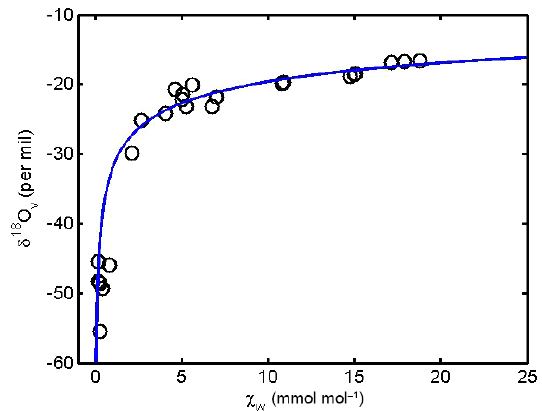
Figure 2. Aircraft observations of the oxygen isotope composition of water vapor ( δ 18 O v ) measured over a forested landscape in New England, United States (He and Smith, 1999; their Table 2). Data from three campaigns show that δ 18 O v follows a power law func- tion ( y = − 32 . 1 χ − 0 . 213 w ) of water vapor mixing ratio ( r 2 = 0 . 98, n = 24, p <0.0001).